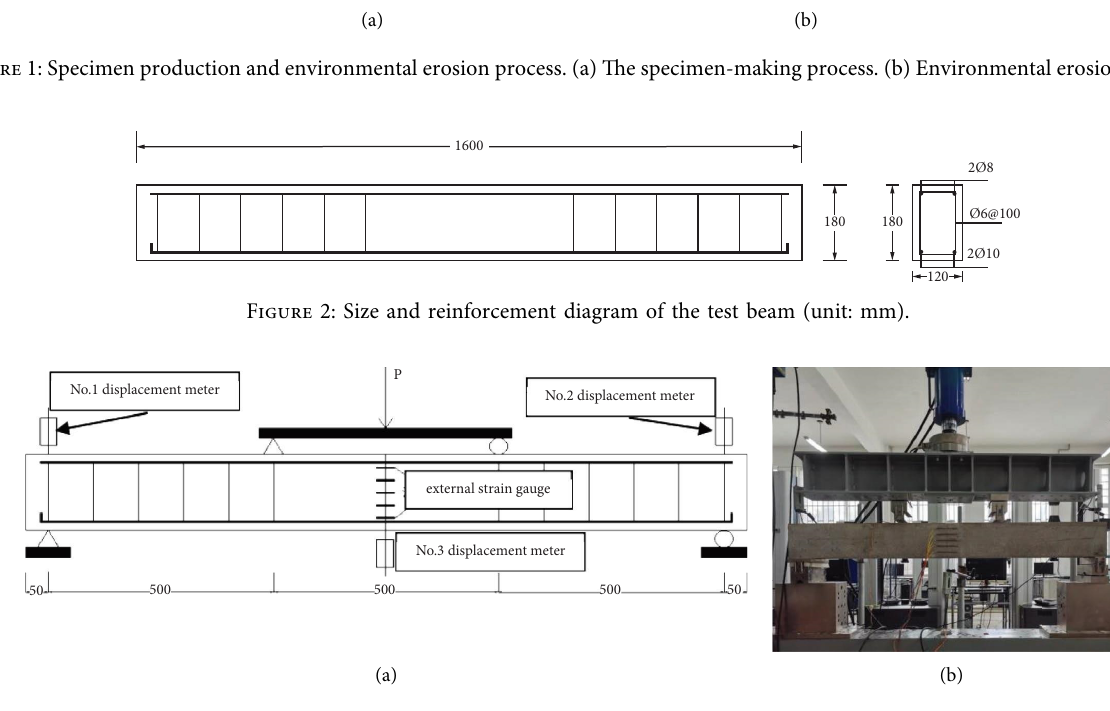
Figure 3: Layout of measuring points and loading device diagram. (a) Layout of measuring points. (b) Loading